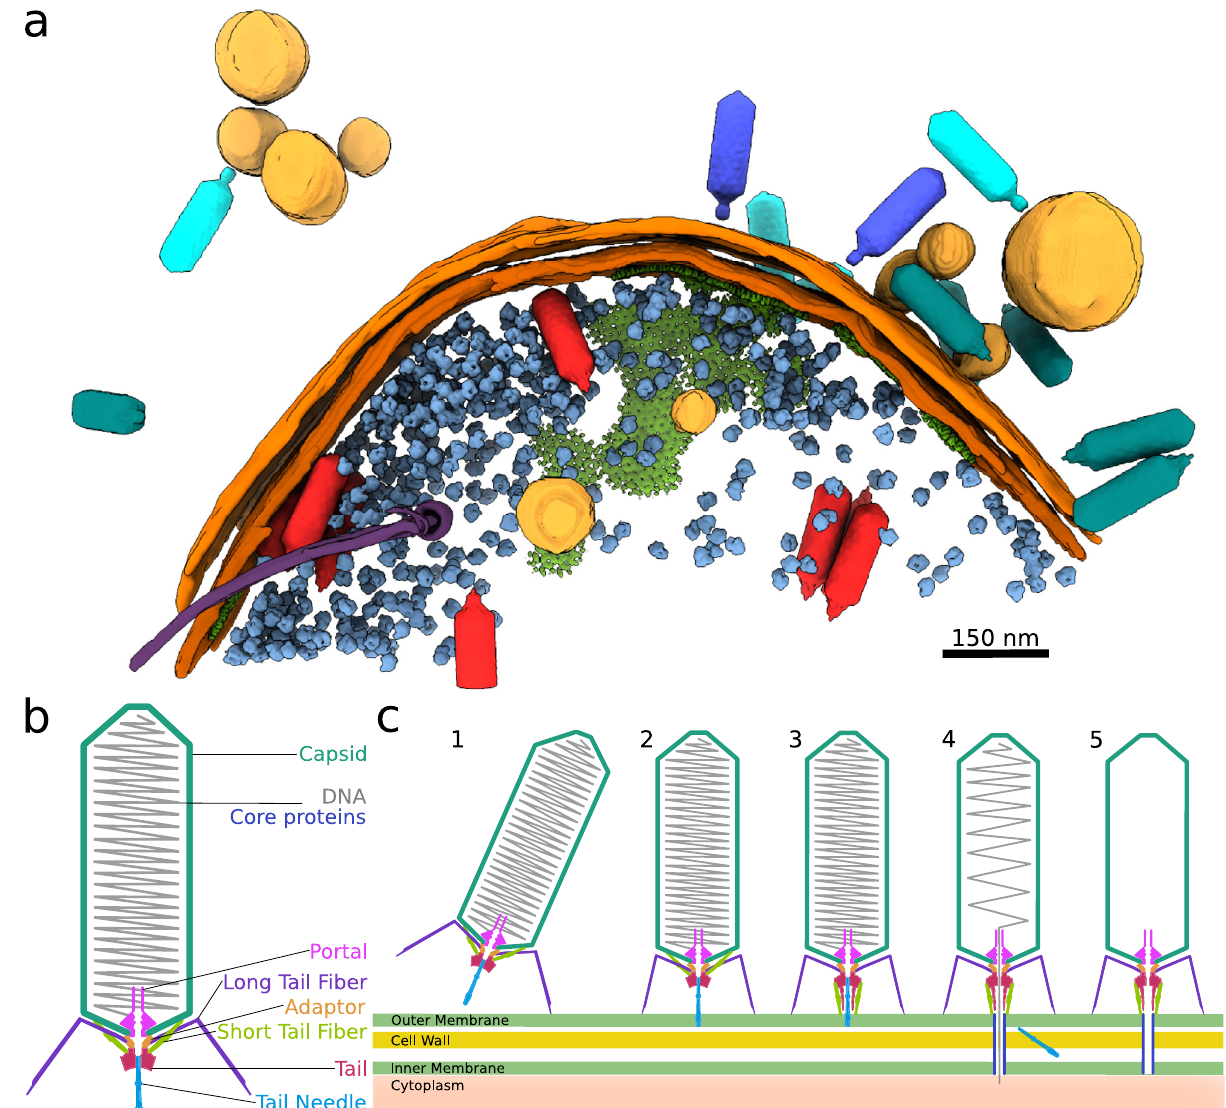
b Scheme of SU10 virion. c Mechanism of SU10 attachment and genome delivery. (1)TheSU10virionattachestoacellsurfacevialongtail fi bers.(2)Thebindingofall six long tail fi bers positions the phage with its long axis perpendicular to the